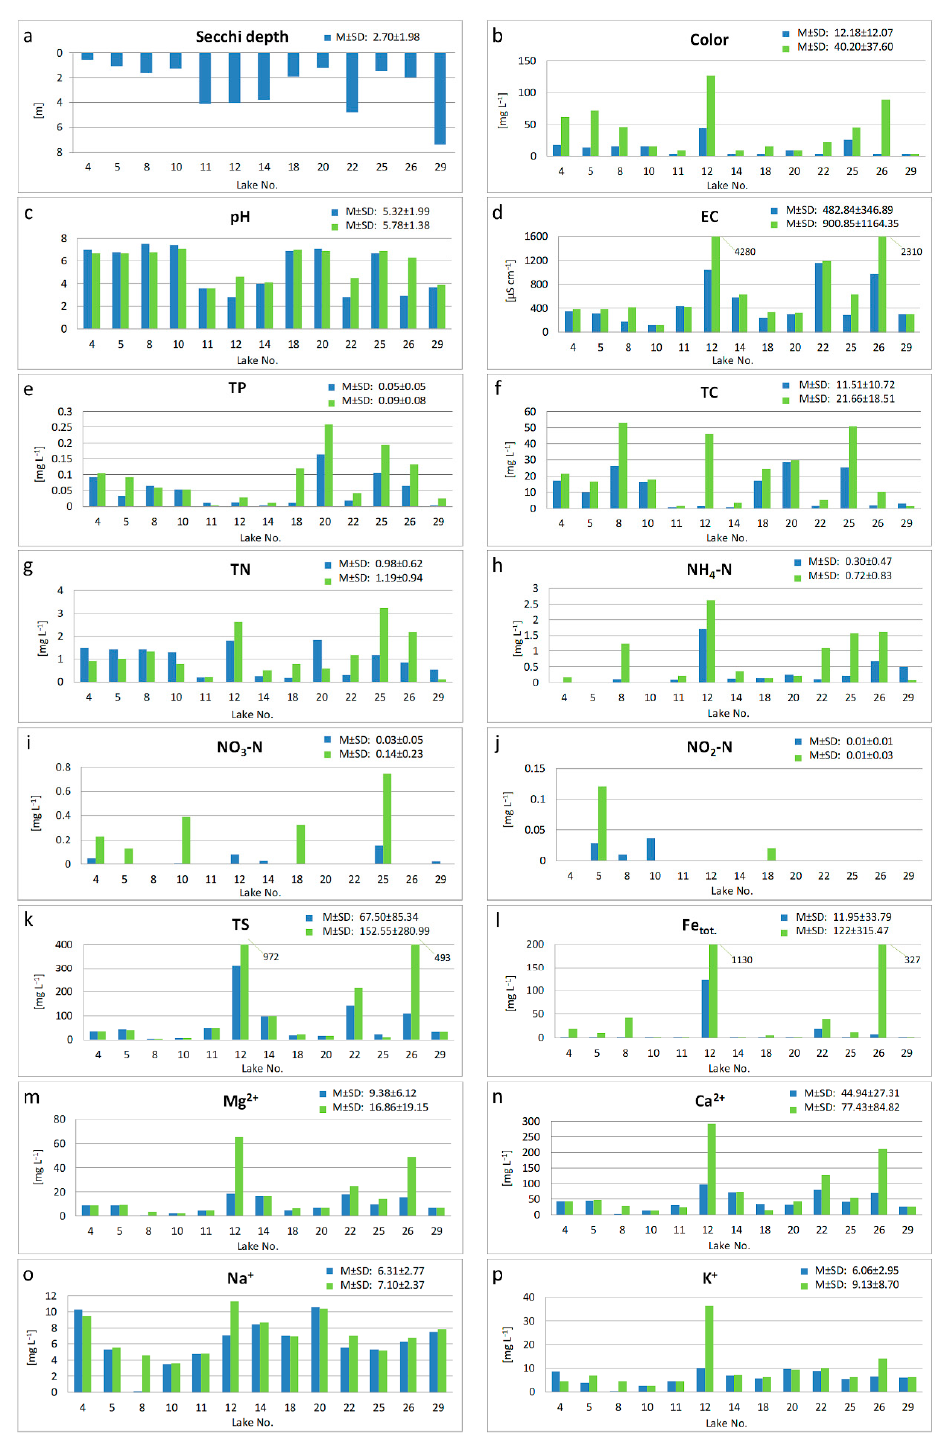
Figure 2. Physicochemical characteristic of the studied lakes: ( a )—Scecchi depth, ( b )—color, ( c )—pH, ( d )—electrical conductivity, ( e )—total phosphorus, ( f )—total carbon, ( g )—total nitrogen, ( h )—ammonium nitrogen, ( i )—nitrate nitrogen, ( j )—nitrite nitrogen, ( k )—total sulphur, ( l )—total iron, ( m )—magnesium, ( n )—calcium, ( o )—sodium, ( p )—potassium. Blue column—epilimnion water, green column—hypolimnion water. M ± SD indicates the mean and standard deviation.